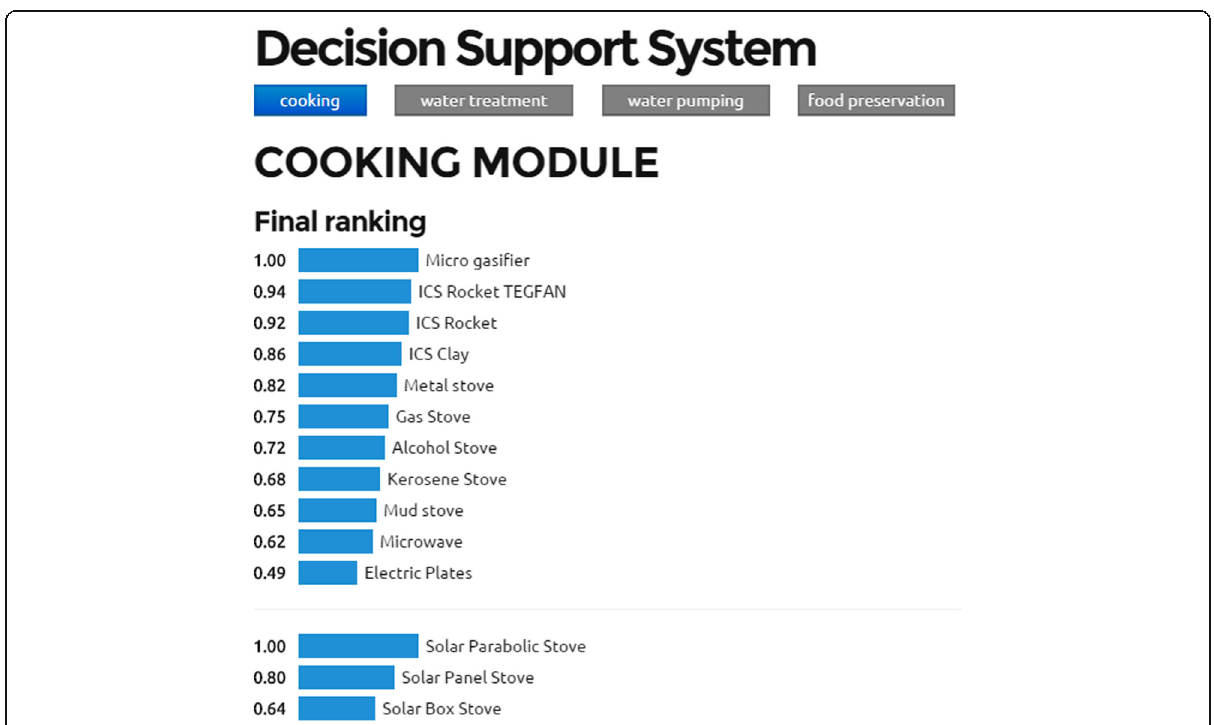
Fig. 10 Example of final ranking (cooking